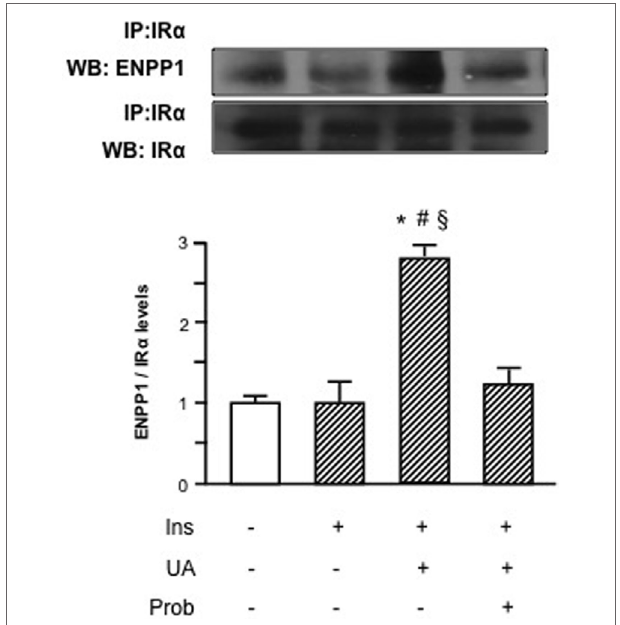
FigUre 4 | Effects of the SLC22A12 (URAT1) inhibitor Probenecid on uric acid (UA)-mediated ectonucleotide pyrophosphatase/phosphodiesterase 1 (ENPP1) binding to insulin receptor (I R ) in human umbilical vein endothelial cells (HUVECs). In presence of insulin and UA, there is a significant reduction of I R binding to ENPP1 when HUVECs are treated with Probenecid. To normalize the blots for protein levels, after being immunoblotted with anti-ENPP1, the blots were stripped and reprobed with anti- α -subunit of insulin receptor (I R α ) total levels. Each bar represents the mean ± SD of three independent experiments and autoradiographs of a representative experiment are shown. * P < 0.05 vs basal value; # P < 0.05 vs insulin; § P < 0.05 vs insulin + UA +